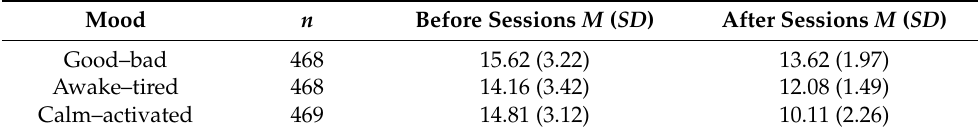
n = number, M = mean, SD = standard